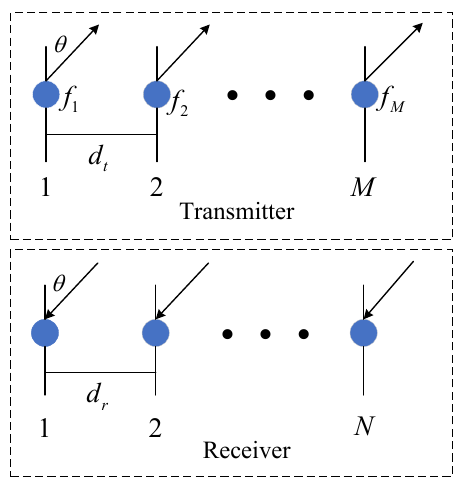
Figure 1. Monostatic FDA-MIMO